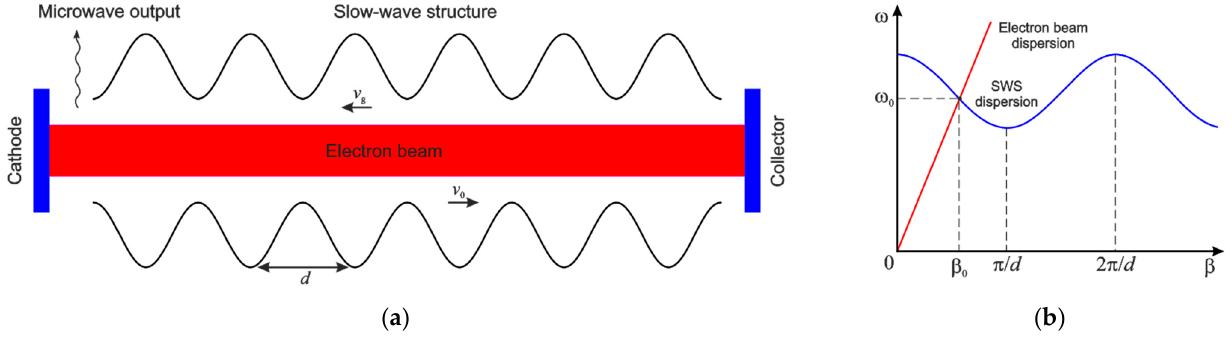
Figure 1. Schematic of the proposed BWO ( a ) and dispersion diagram ( b ) illustrating beam ‐ wave synchronism.